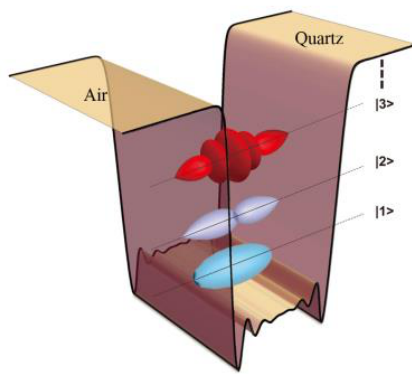
Figure 1: A metal quantum well structure is formed based on an ul- trathin gold film sandwiched between the quartz substrate and air Figure 1 . A metal quantum well structure is formed based on an ultrathin gold film sandwiched between the quartz substrate and air on top. The first three lowest energy levels and their corresponding on top. The first three lowest energy levels and their corresponding wave functions are also sketched. The shape deformation of the wave functions are also sketched. The shape deformation of the well well bottom indicates the impact of electron distribution. bottom indicates the impact of electron distribution.